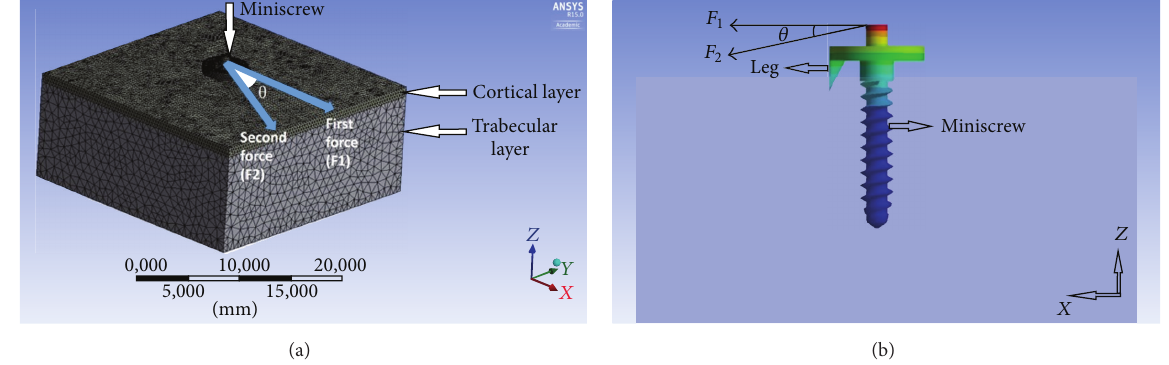
Figure 1: (a) FEM for miniscrew stability. (b) Force positions for the stability analysis.